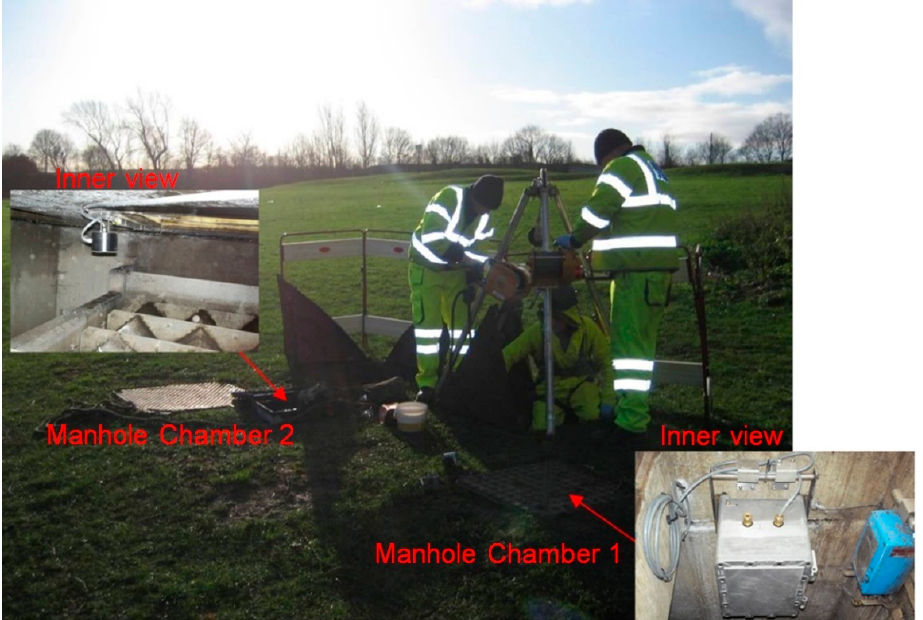
Figure 12. Practical implementation of the proposed acoustic system used in phase 2 field experi- ments.